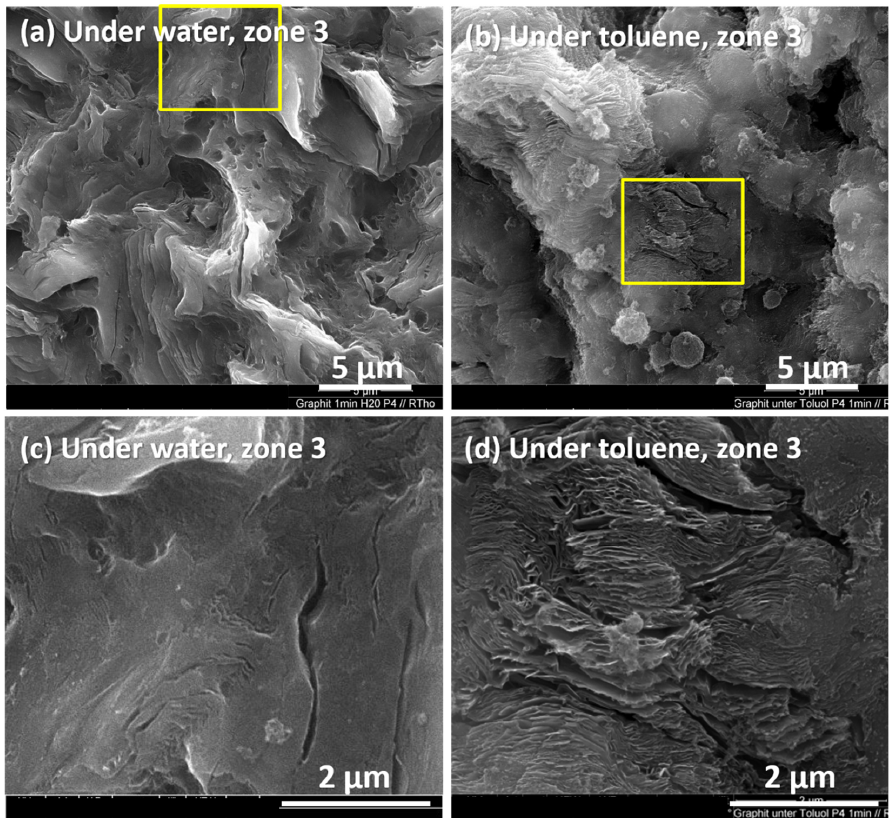
Figure 10. Zone 3. SEM images of graphite targets irradiated using a laser under a 0.3 mm thin liquid film: ( a , c ) under water and ( b , d ) under toluene. ( c , d ) are zoomed from the square frames in ( a , b ).